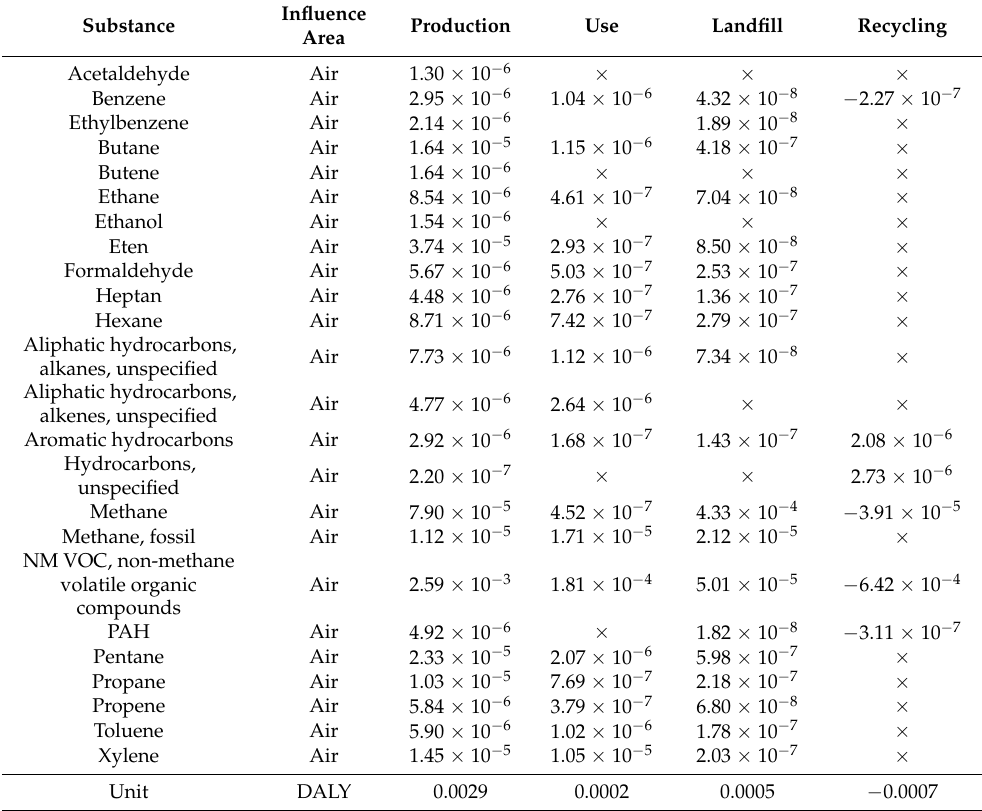
Table 4. The results of the studies characterizing the environmental consequences for organic compounds causing respiratory diseases for individual stages of the life cycle of the Vestas V90, DALY [own